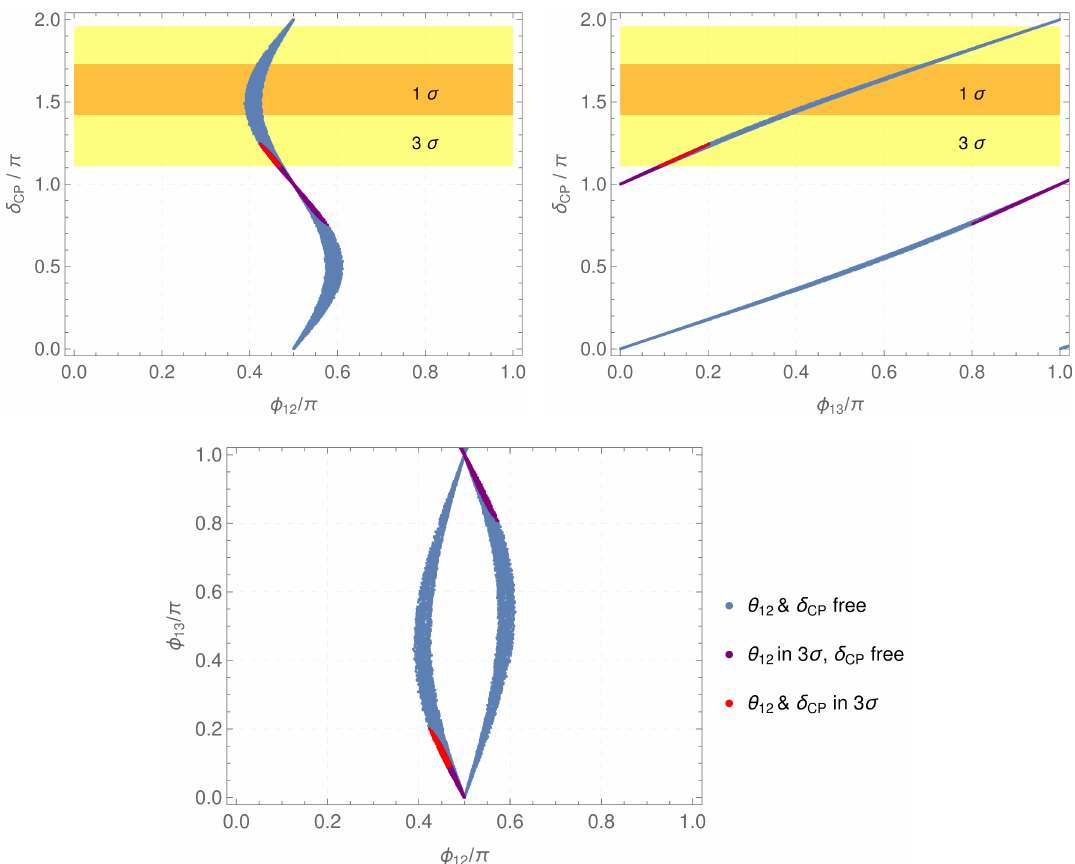
Figure 3 . Correlations between physical phases in the IO case. Left up: correlation between φ 12 and δ . Right up: correlation between φ and δ . Down: correlation between the Majorana CP 12 CP phases φ and φ . In all the plots blue dots arise when the other observables are fitted inside 13 13 their 3 σ experimental ranges except for θ and δ , which are free. In addition, purple dots fit θ 12 CP and red dots also fit δ at the 3 σ level. By imposing all the experimental constraints, the model CP predicts δ 1 . 2 π , φ 0 . 45 π and φ 0 . 12 π plus a small CP ≈ 12 ≈ 13 ≈